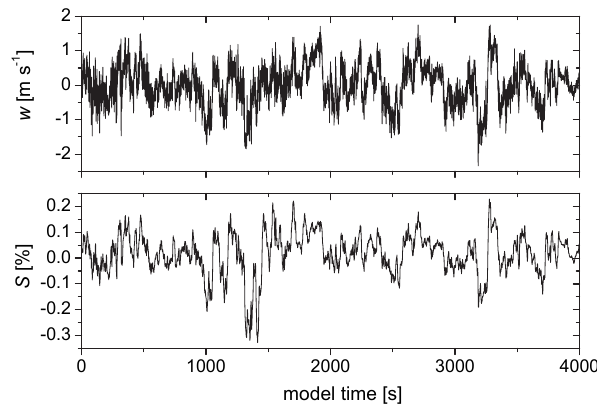
Fig. 10. Time series of vertical wind velocity (upper panel) driving the cloud parcel model and modelled supersaturation (lower panel) corresponding to during model run A1. Table 1. Initial vertical wind velocity ( w init ), mean height ( h ), mean liquid water content (LWC), standard deviation ( σ S 0 ) and peak to peak values (p2p) of the supersaturation fluctuations ( S 0 ) for six model runs. All model runs feature a model cloud base of 1065m